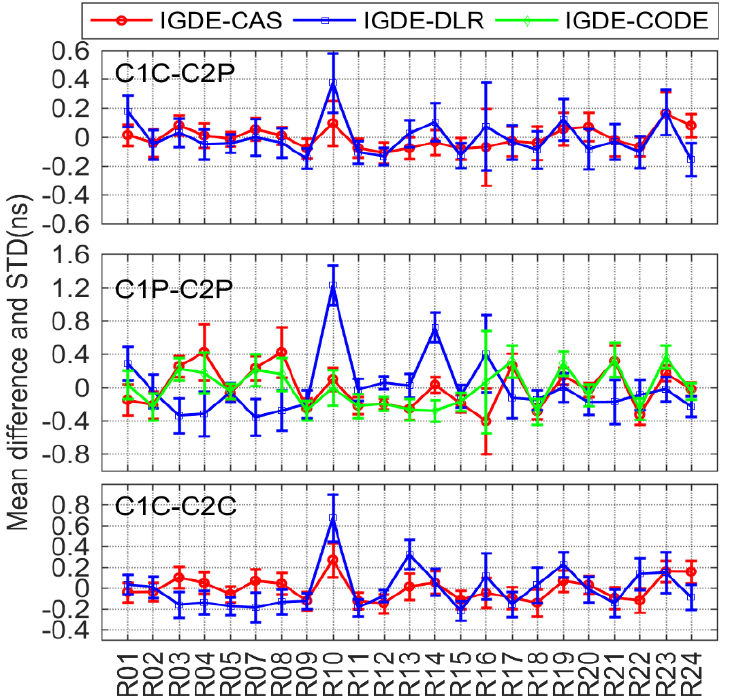
Figure 8. Mean difference and STD of GLONASS DCB between IGDE and MGEX products. For BDS, only two types of DCB (C2I-C7I for BDS-2 and C2I-C6I for BDS-2 and BDS- 3) observations could be tracked by satellites based on the current MGEX network. The corresponding DCB products could be obtained from CAS and DLR, and the comparison result is shown in Figure 9. It can be seen that the mean difference between two types of DCB with respect to CAS and DLR was within ±0.6 ns. For C2I-C7I and C2I-C6I, there was a mean RMS of 0.25/0.14 and 0.24/0.22 ns, respectively, with respect to CAS/DLR.